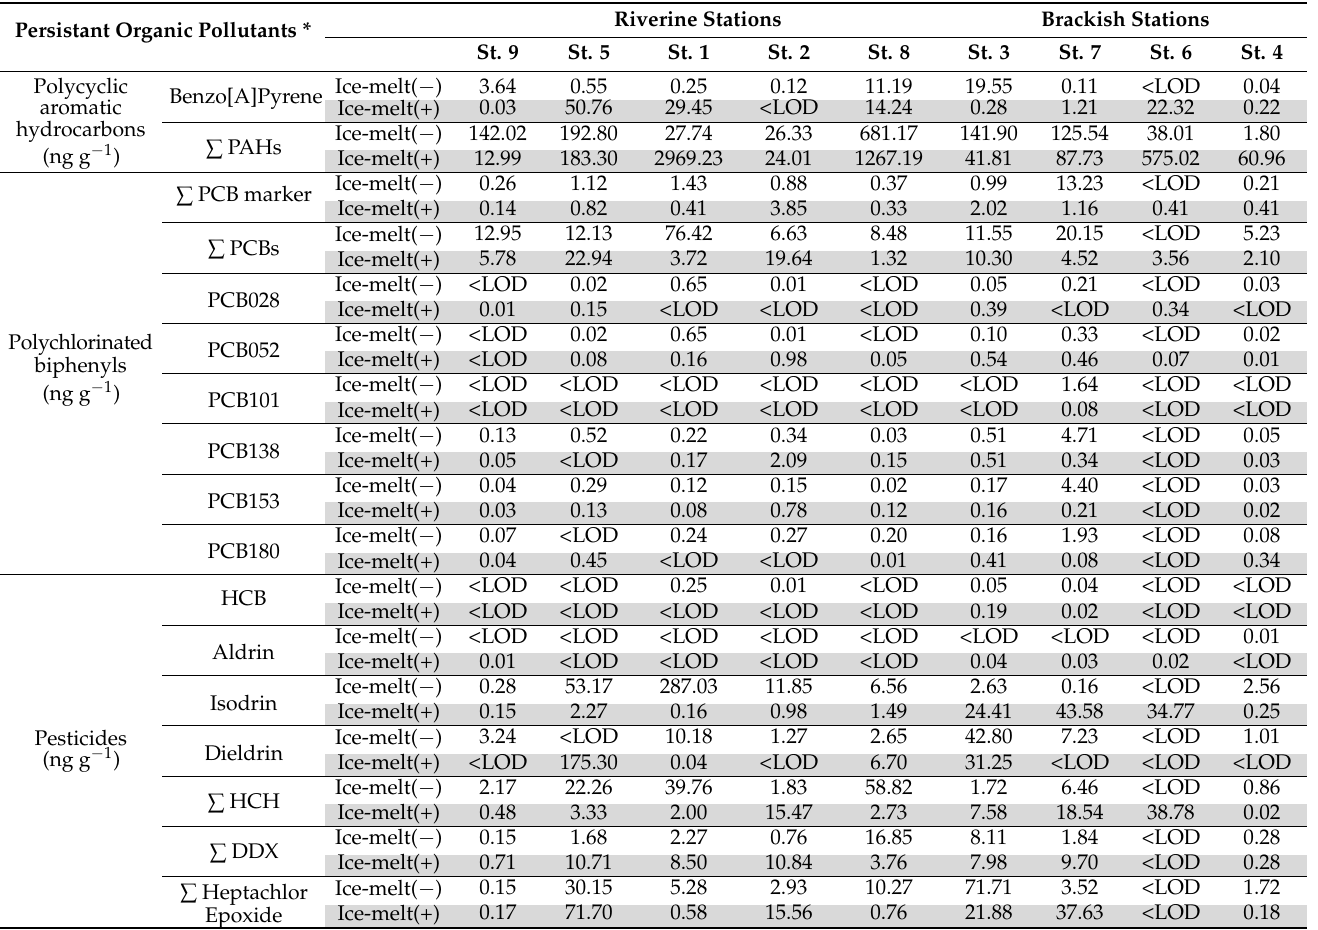
Table 2. Persistent organic pollutant concentrations (ng g − 1 dry weight) in sediment samples collected in 2014 during Ice-melt( − ) and Ice-melt(+) conditions in the Pasvik River. * <LOD, below the limit of